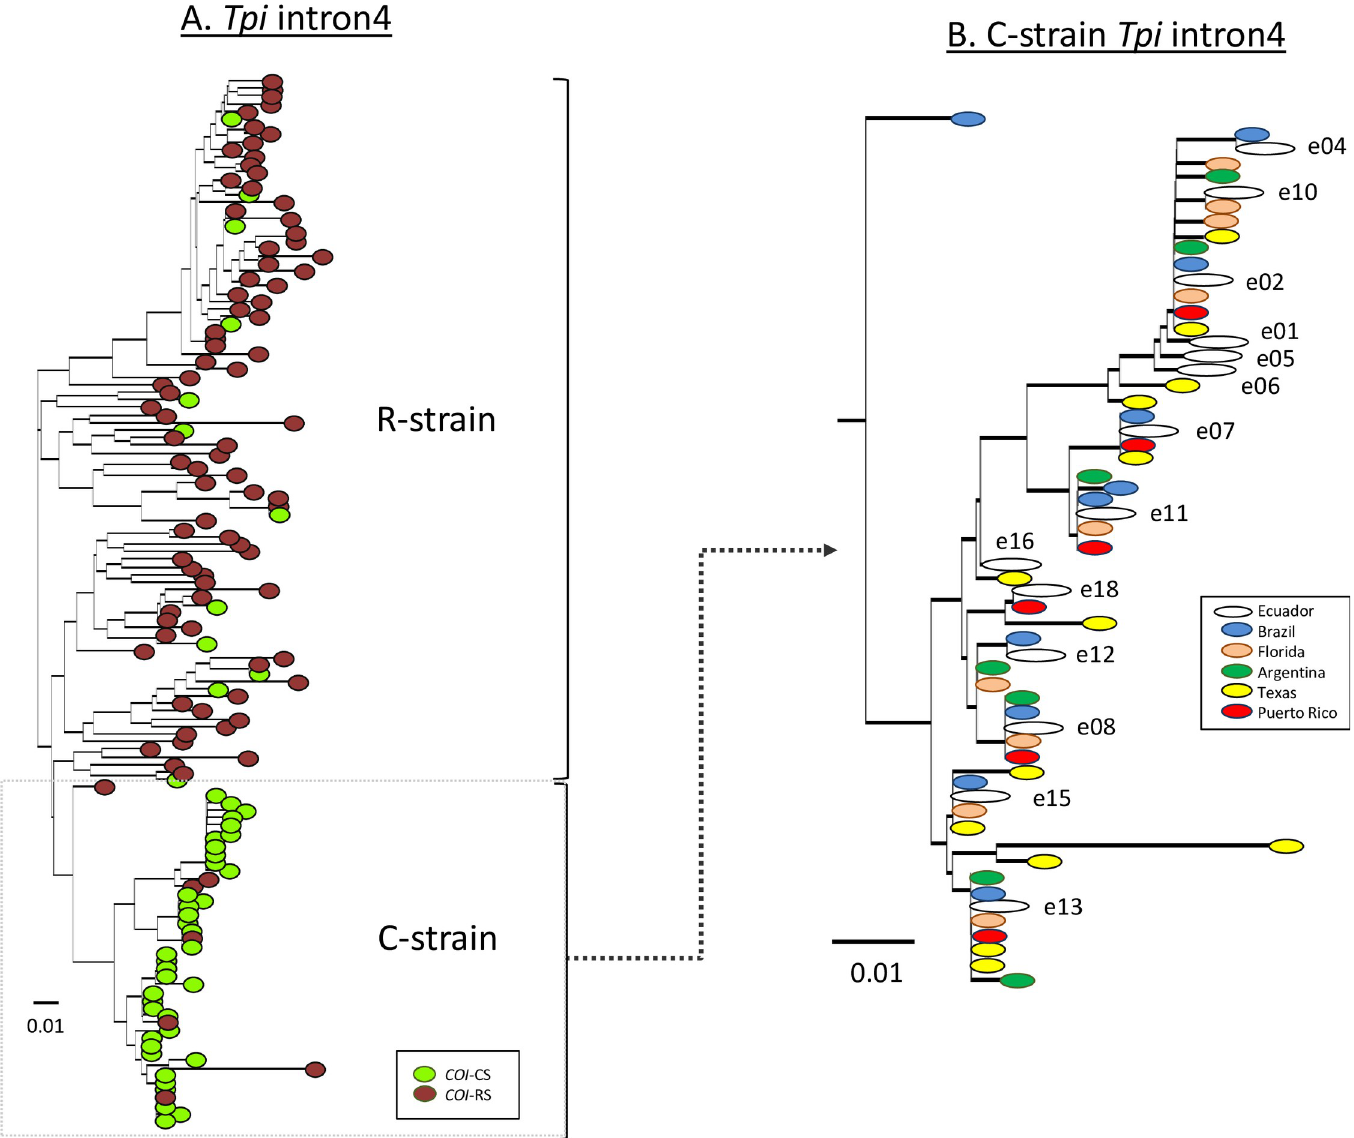
Fig 5. Phylogenetic tree inferred by using the neighbor-joining method and Tamura-Nei genetic distance model [56]. The 14 Ecuador TpiI4 intron variants were compared to 84 unique haplotypes found from 138 Western Hemisphere larvae. A: The phylogenetic tree color-coded for the expression of COI -CS or COI -RS. B: The C- strain section of the phylogenetic tree where all 14 Ecuador sequences clustered is shown in expanded form and color-coded by location. Scale bar represents substitutions per site.